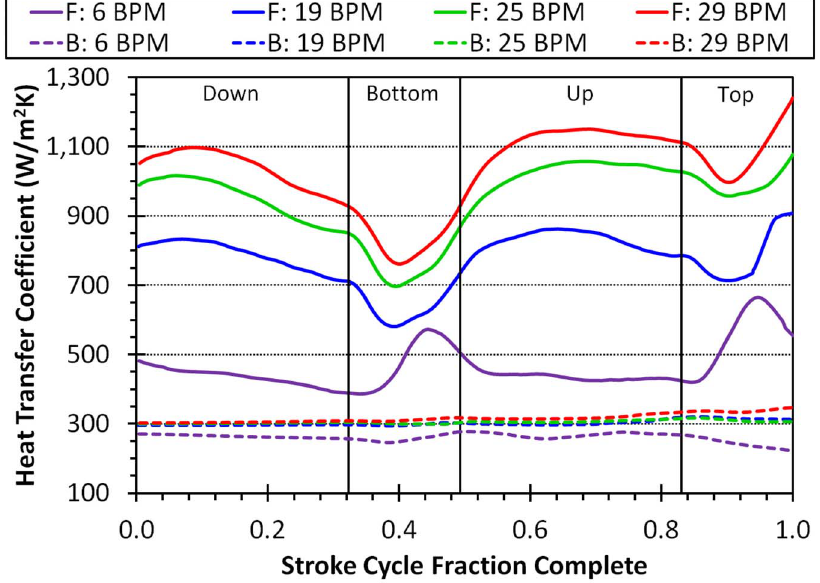
Figure 10. The heat transfer coefficients of our simulated juvenile turtles they go through one stroke period. B and F stand for the heat transfer coefficient on the body and flipper, respectively. The vertical black lines demark the four different stroke phases (down, bottom, up, and top). Since each swimming frequency has its own period, the x-axis is percent of stroke completed.